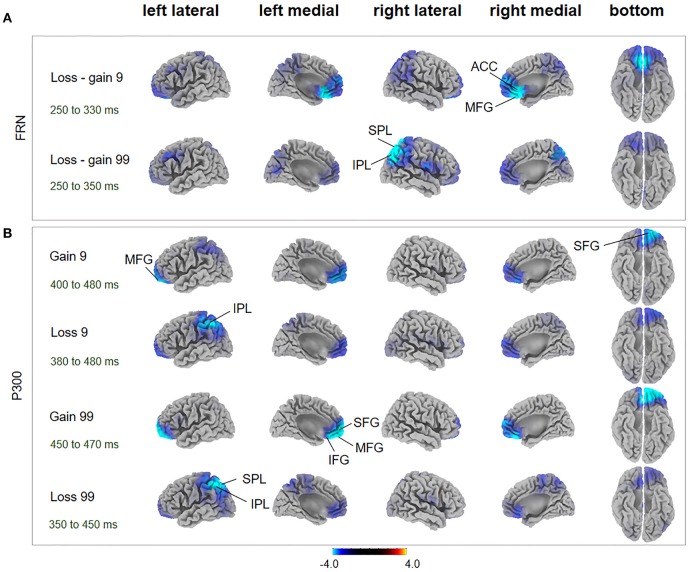
FRN and P300 source localization and between-subject comparison. The t-score maps for comparisons between AHAs and HCs for the FRN (A) and P300 (B) components are shown for low- and high-risk options, as well as feedback outcomes, respectively. The brain regions labeled with yellow/red indicate AHAs > HCs, while green/blue indicates AHAs < HCs. The time periods for different components are also indicated. Significant brain regions (p < 0.05, FWE corrected) are indicated on the map. The peak MNI coordinate regions for each comparison are reported in Table 1. ACC, anterior cingulate cortex; IPL, inferior parietal lobule; IFG, inferior frontal gyrus; MFG, middle frontal gyrus; SPL, superior parietal lobule; SFG, superior frontal gyrus.